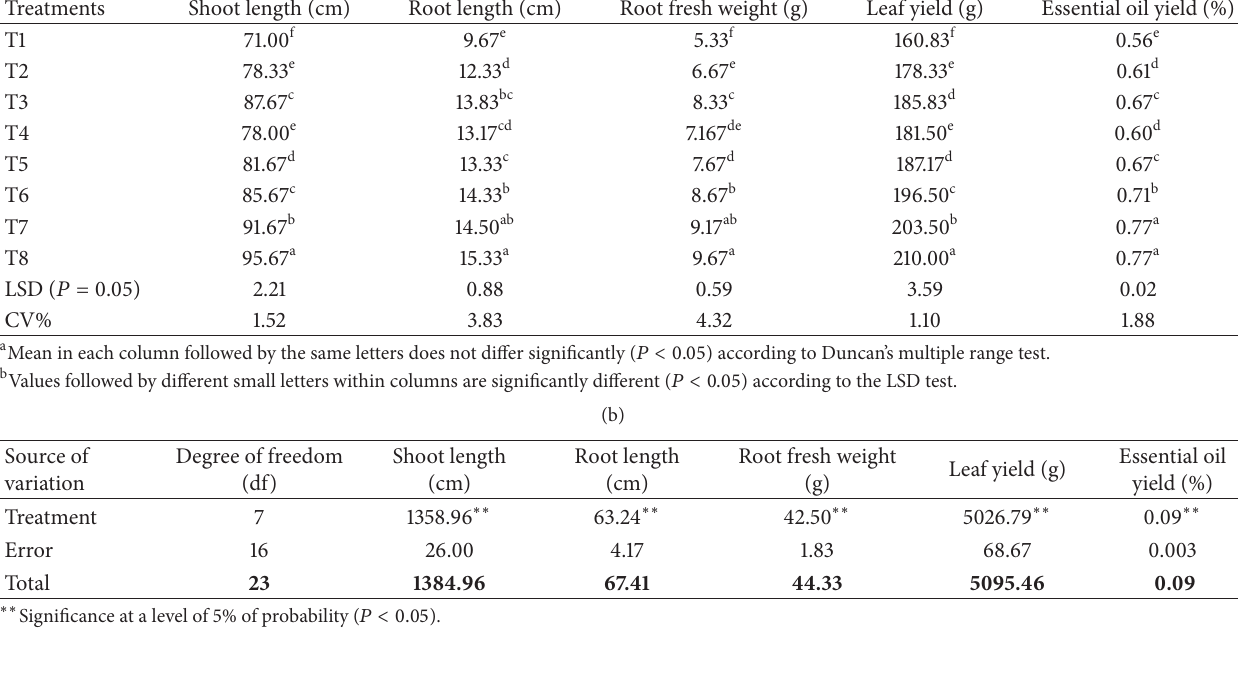
Table 3: (a) Effect of rhizospheric microbes on nutrient uptake in